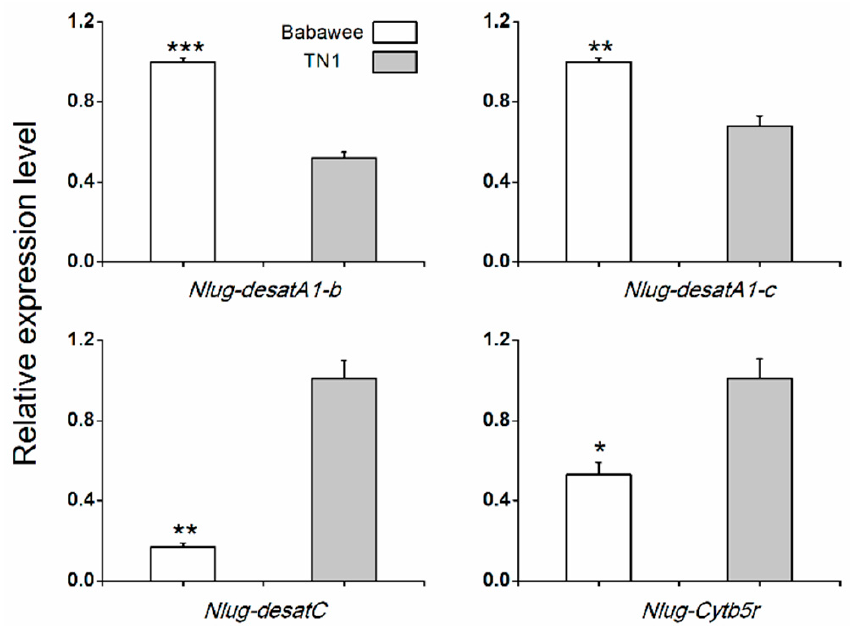
Figure 6. Mean transcript levels (+SE, n = 3) of 4 desaturase genes in BPH population reared on rice variety Babawee or TN1. The results (threshold cycle values) of the qRT-PCR assays were normalized to the expression level of RPS15 (ribosomal protein S15e, GenBank accession number: ACN79501.1). Asterisks indicate significant difference between treatments ( * P < 0.05, ** P < 0.01 and *** P < 0.001, Student’s t